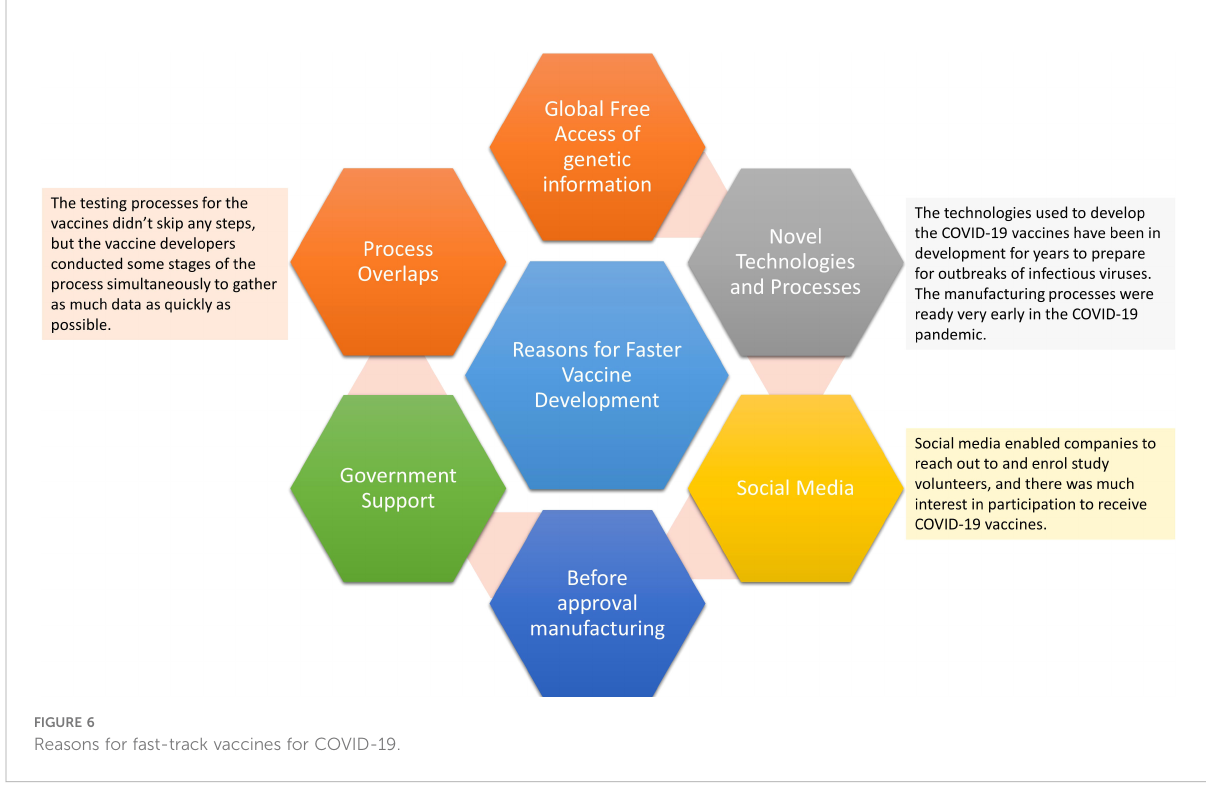
FIGURE 6 Reasons for fast-track vaccines for COVID-19.